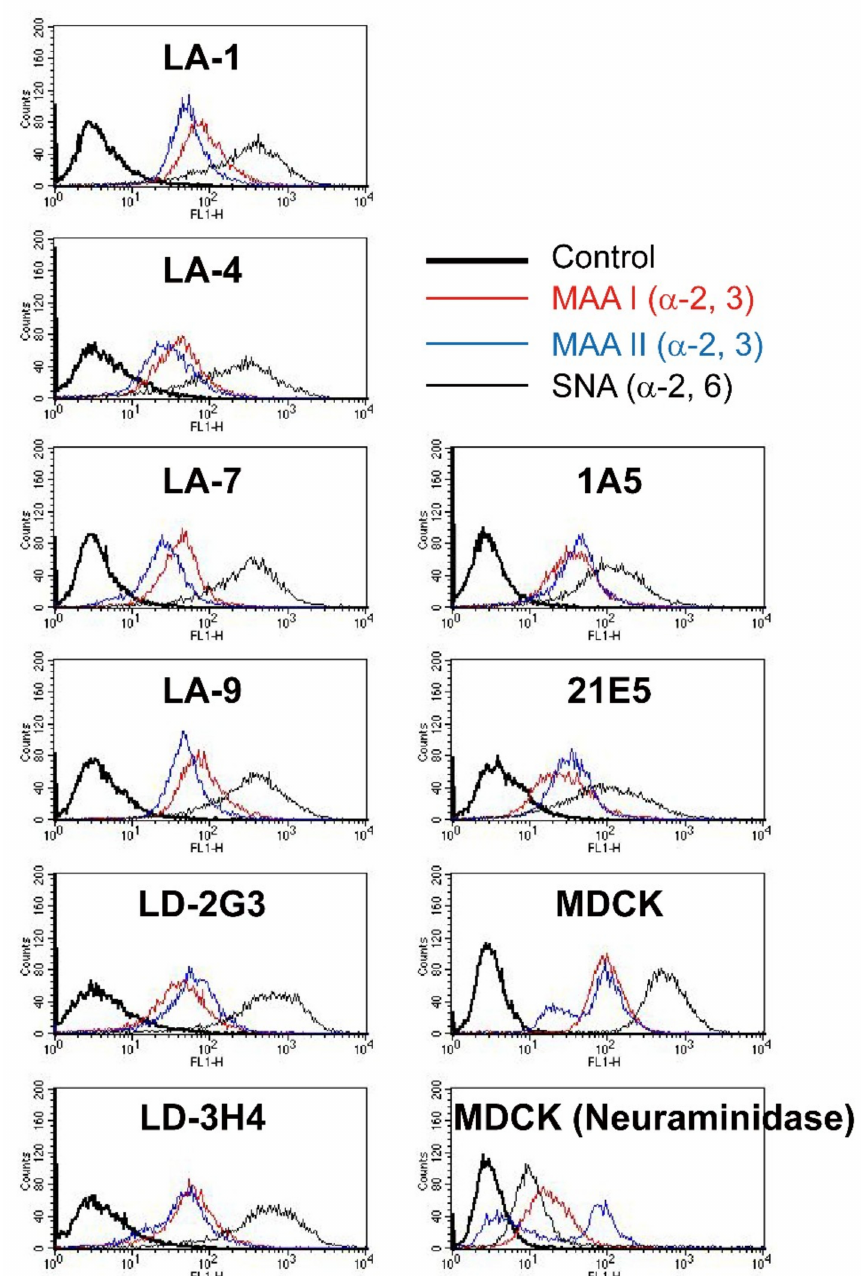
Figure 2. Expression of virus receptors by human tracheal epithelial cell clones. The expression of sialic acid (SA) receptors on the surface of the HTEpC-T clones was analyzed by flow cytometry. α 2,3SAGal and α 2,6SAGal receptors were detected by Maackia amurensis (MAA) and Sambucus nigra (SNA) lectins, respectively. α 2,3SAGal residues are shown in red (when detected by MAA-I) or blue (when detected by MAA-II). α 2,6SAGal is shown as a black line. Control cells (without lectin) are represented by the black bold line. SAEC-T clones (1A5 and 21E5), which were derived from primary human bronchiolar epithelial cells, were also examined, and receptor expression patterns were compared with those of HTEpC-T clones. Madin–Darby canine kidney (MDCK) cells (virus-susceptible controls) express both α 2,3SA and α 2,6SA receptors. MDCK cells were first treated with neuraminidase to confirm the reliability of lectin